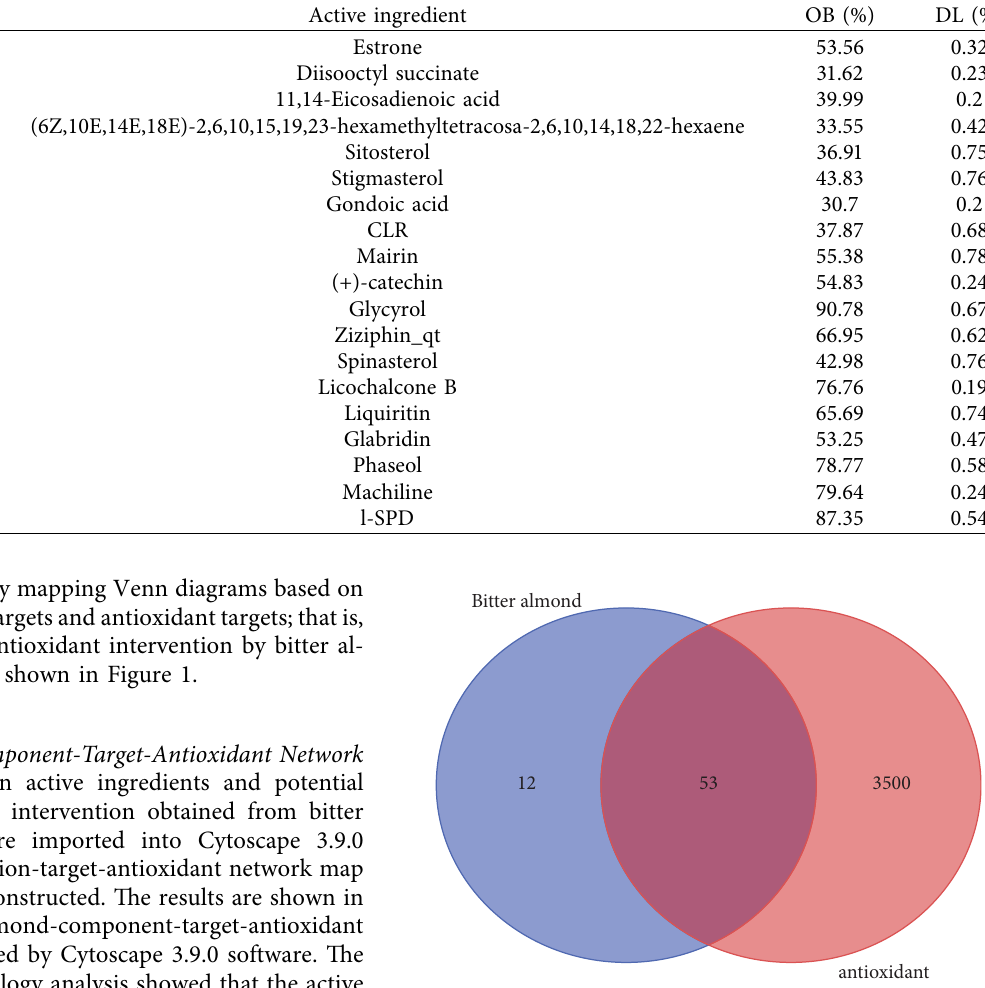
Figure 1: Venn diagram of bitter almond and antioxidant